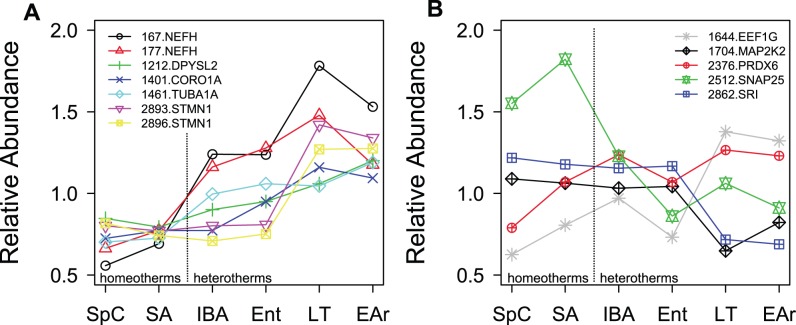
Abundance of protein spots important for separating clusters.The relative abundance of (A) cytoskeletal elements and binding proteins and (B) non-cytoskeletal proteins highlighted by Random Forests as important inputs for hibernation state clustering (Fig. 3). Mean values in each base state are plotted for spots that also had ≥1.5X maximum fold change. A broken vertical line divides the sequential homeothermic from heterothermic states.